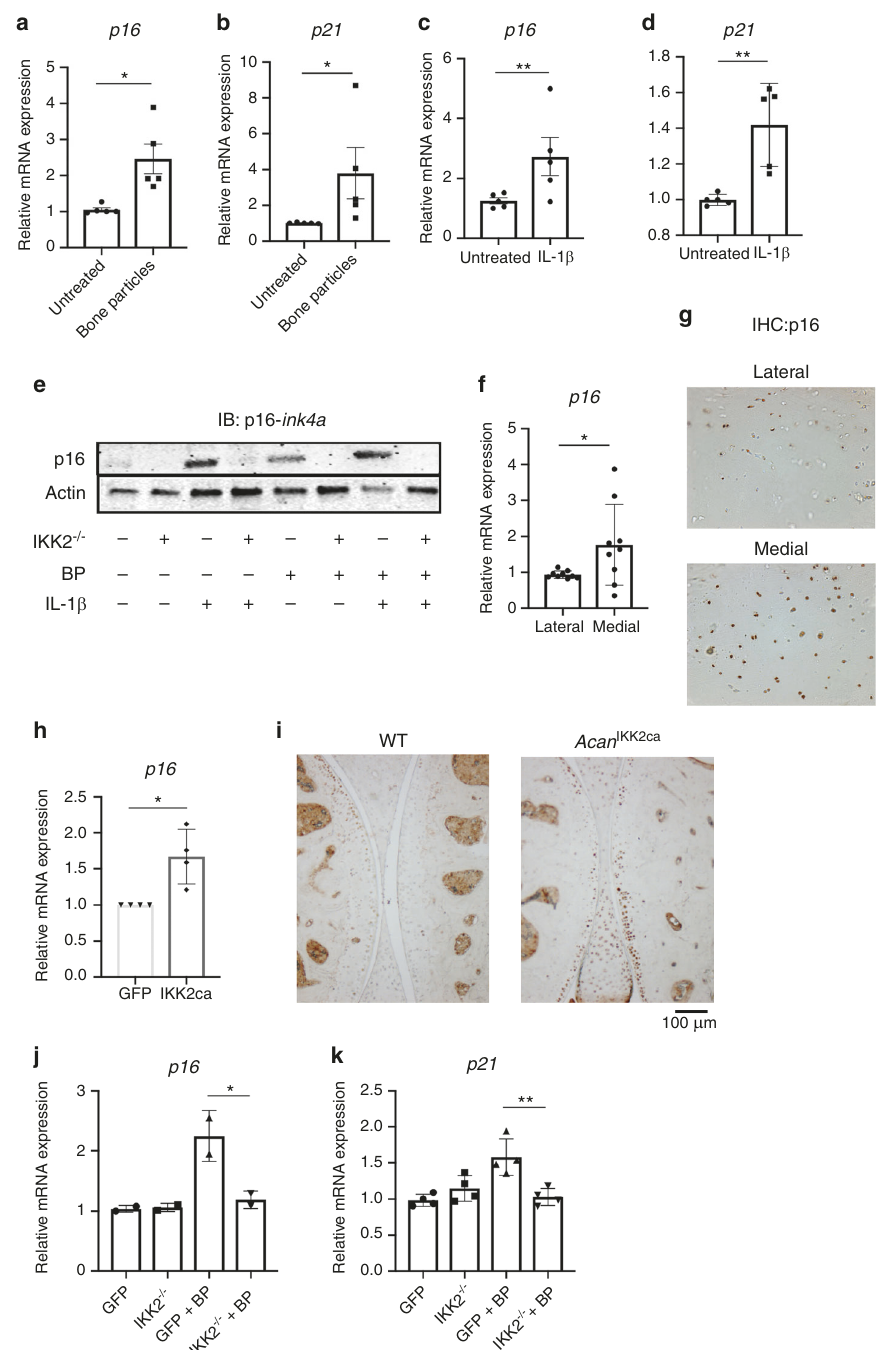
Fig. 5 In fl ammatory mediators promote senescent changes in chondrocytes. a – d Chondrocytes were exposed to BP or IL-1 β for 24 h. Gene expression analysis was performed for p16 or p21 (A: p16 : * P = 0.051 1. B: p21 : * P = 0.022 9. C: p16 : ** P = 0.009 6. D: p21 ** P = 0.003 9). Bars represent mean ± SEM for n = 5 independent experiments . e Adeno-GFP or adeno-cre were transduced into IKK2 − / − chondrocytes. Cells were then treated with BP and/or IL-1 β for 24 h. After 24 h, protein lysates were collected and immunoblotting was performed for p16-Ink4a. Representative immunoblot image is shown. f Medial and lateral knee articular cartilage was isolated from patients undergoing TKA with medial compartment OA. P16 gene expression was measured by qPCR ( P = 0.053 0). Bars are mean ± SD for n = 9 patients. g Medial and lateral knee articular cartilage was isolated from patients undergoing TKA with medial compartment OA. Cartilage tissue was sectioned and IHC was carried out for p16-Ink4a. Image is representative of n = 4 healthy and diseases cartilage sections. h GFP or IKK2ca were retrovirally transduced into chondrocytes. p16 expression was measured by qPCR (* P = 0.012 2). Bars are mean ± SD from n = 4 independent experiments. i IKK2ca was expressed in chondrocytes of adult mice in vivo under the control of the tamoxifen inducible aggrecan-cre (Acan IKK2ca ). Six weeks post induction, mice were sacri fi ced and joints were embedded in paraf fi n and sectioned. IHC was performed for p16, with dark stain representing p16 positive cells. Representative images are displayed. j , k IKK2 − / − chondrocytes were transduced with adeno-GFP or adeno-cre. Cells were then treated with BP for 24 h and p16 and p21 gene expression was measured (p16: * P = 0.021 2, n = 2. p21: ** P = 0.001 7, n = 4). Bars represent mean ± SD from representative